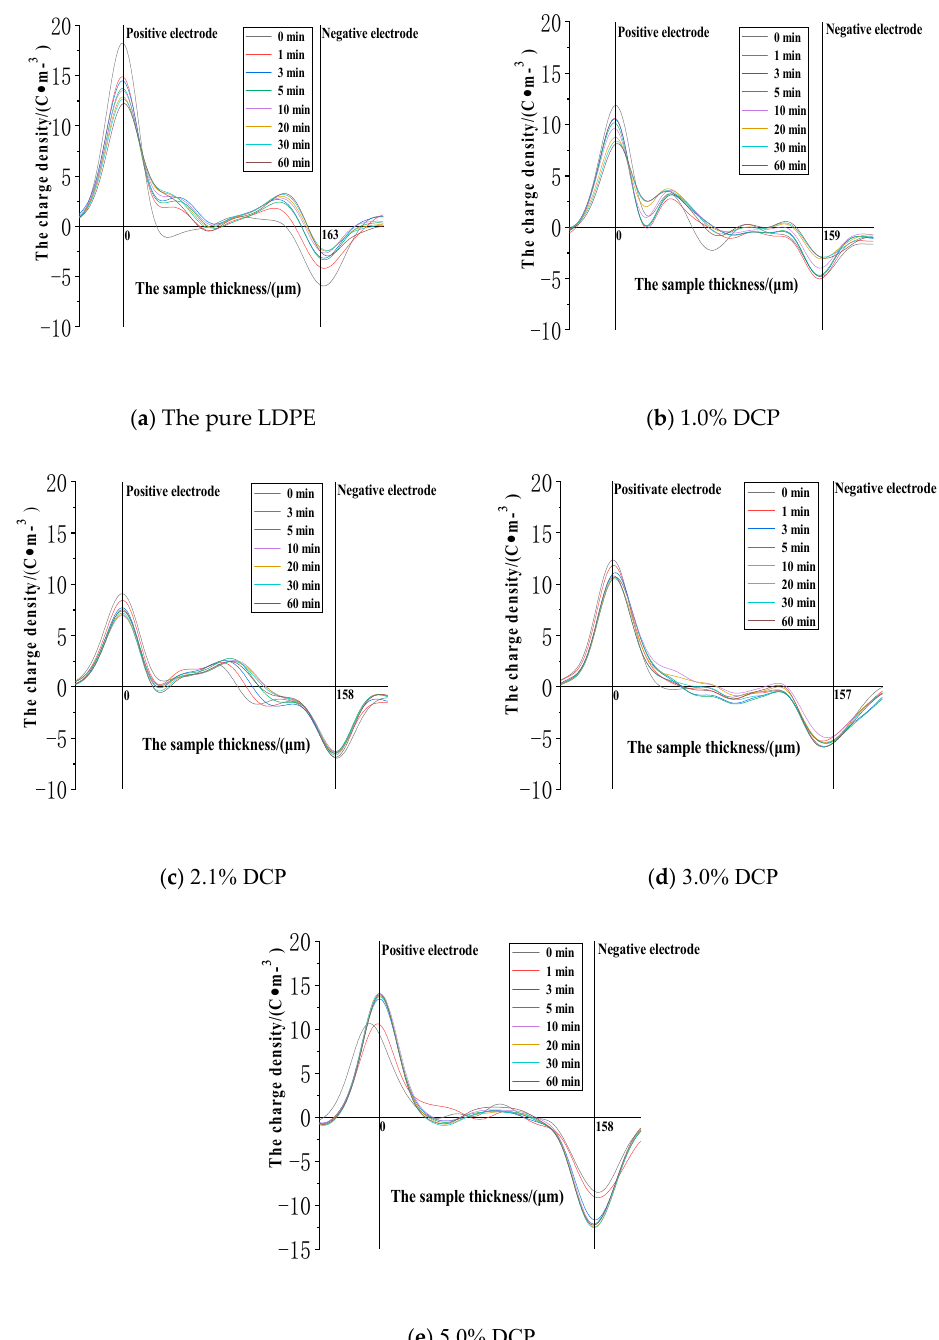
Figure 4. The space charge distribution when voltage is applied to each sample at the electric field strength of 30kV/mm. ( a ) The experimental results of the pure LDPE samples. ( b ) The experimental results of the samples with 1.0% DCP. ( c ) The experimental results of the samples with 2.1% DCP. ( d ) The experimental results of the samples with 3.0% DCP. ( e ) The experimental results of the samples with 5.0% DCP. LDPE: low-density polyethylene.